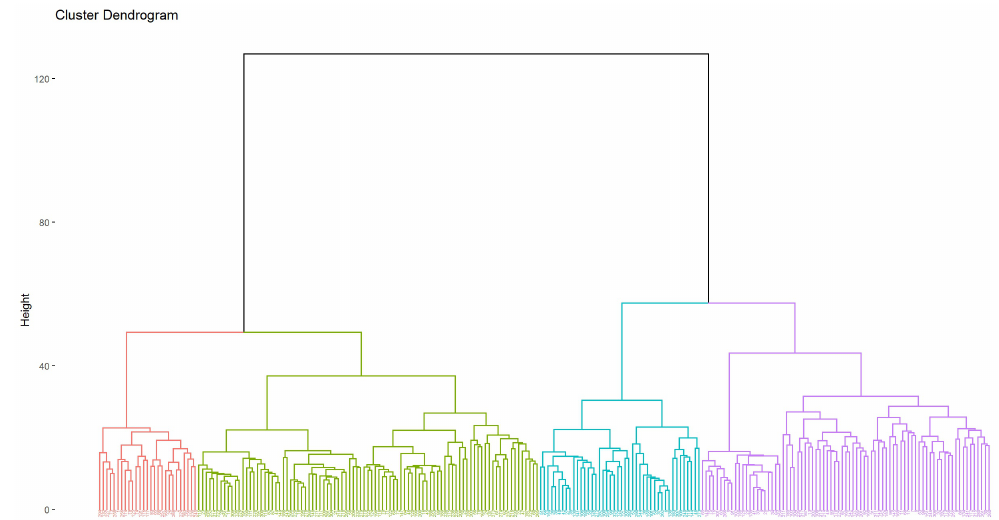
Figure 5. Hierarchical clustering with ACF distance dendrogram.